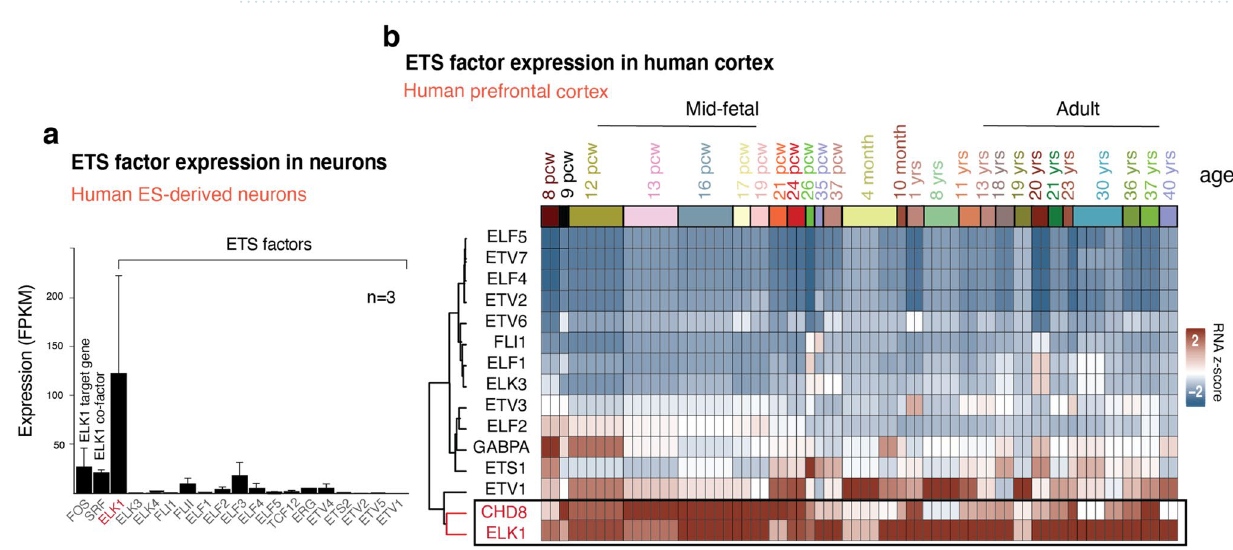
Figure 21. ELK1 is the only highly expressed ETS genes in in-vitro derived human neurons and its expression cluster with CHD8 in human brain. ( a ) Average expression of ETS factors shows ELK1 is the only highly expressed ETS gene in differentiated human neurons (average FPKM values taken from wild type neurons). ( b ) Gene expression of CHD8 and ETS factor analysis in human developing cortex and unsupervised clustering of expression levels (Alan brain data) 37